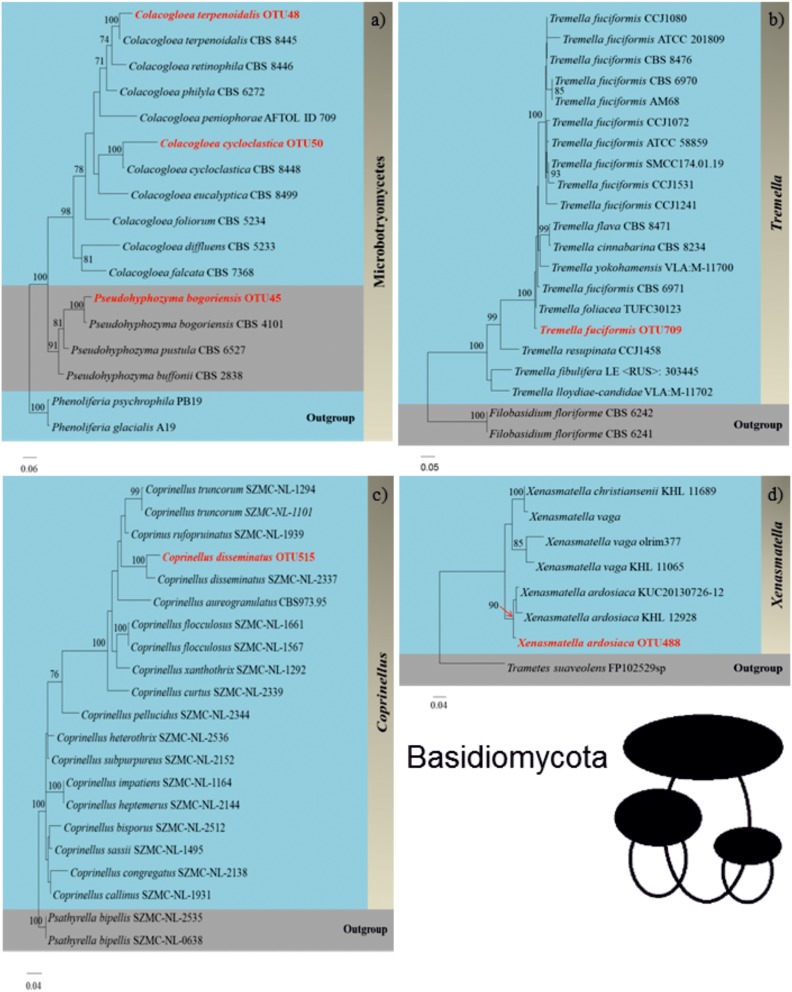
Phylograms (Basidiomycota) of (a)
Colacogloea terpenoidalis, Pseudohyphozyma bogoriensis, and Colacogloea cycloclastica (Microbotryomycetes), (b)
Tremella fuciformis (Tremellomycetes), (c)
Coprinellus disseminatus (Agaricomycetes), and (d)
Xenasmatella ardosiaca (Agaricomycetes) generated by randomized axelerated maximum likelihood analysis based on complete ITS sequences.